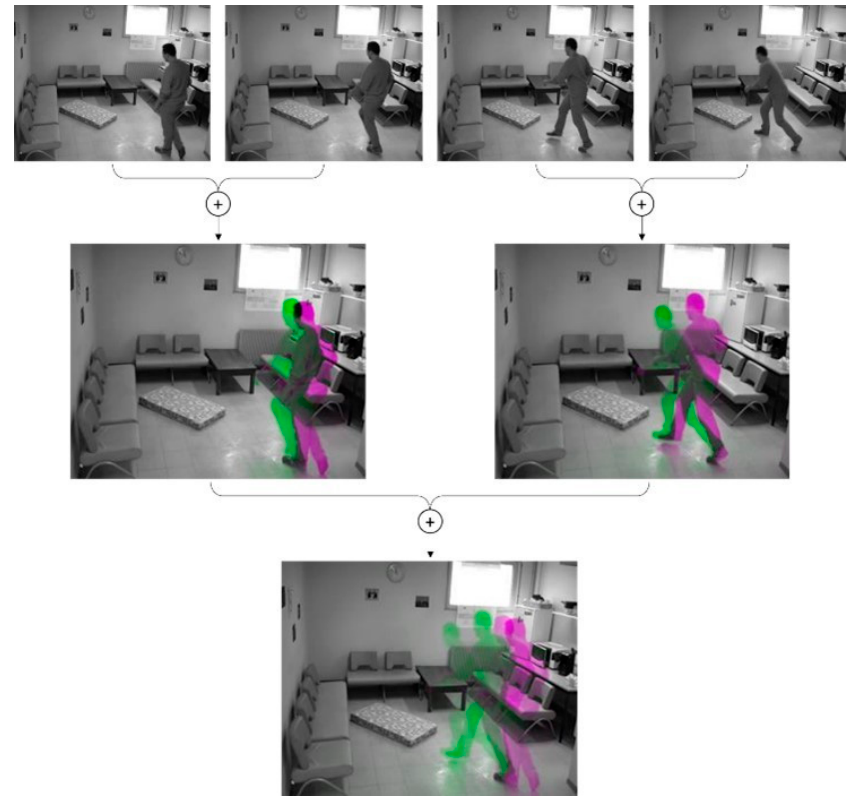
Figure 3. Two-level image fusion of 4 consecutive video frames.